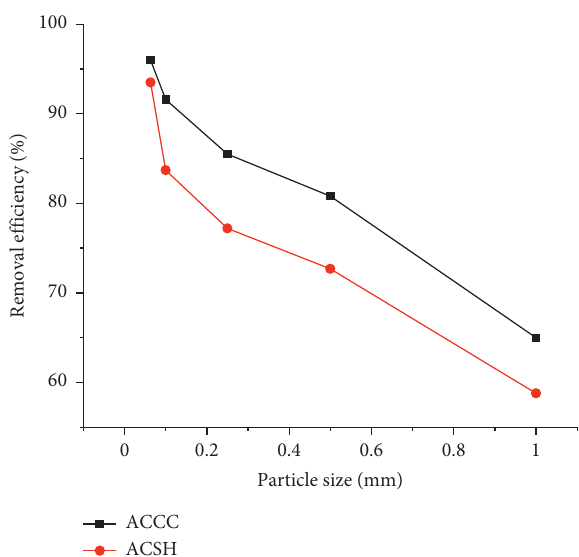
Figure 7: Effect of dose on fluoride removal efficiency of activated carbon of corncob and sorghum husk (contact time � 1h) with an initial fluoride concentration of 5.0 mg/L at pH 7.